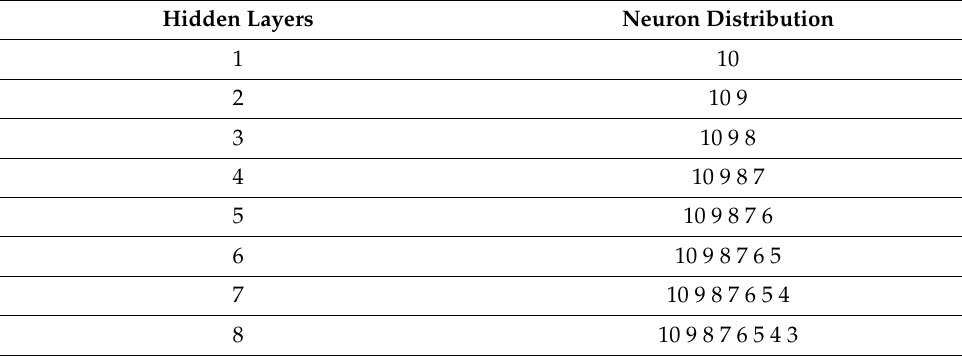
Table 3. Number of hidden layers and the distribution of neurons.